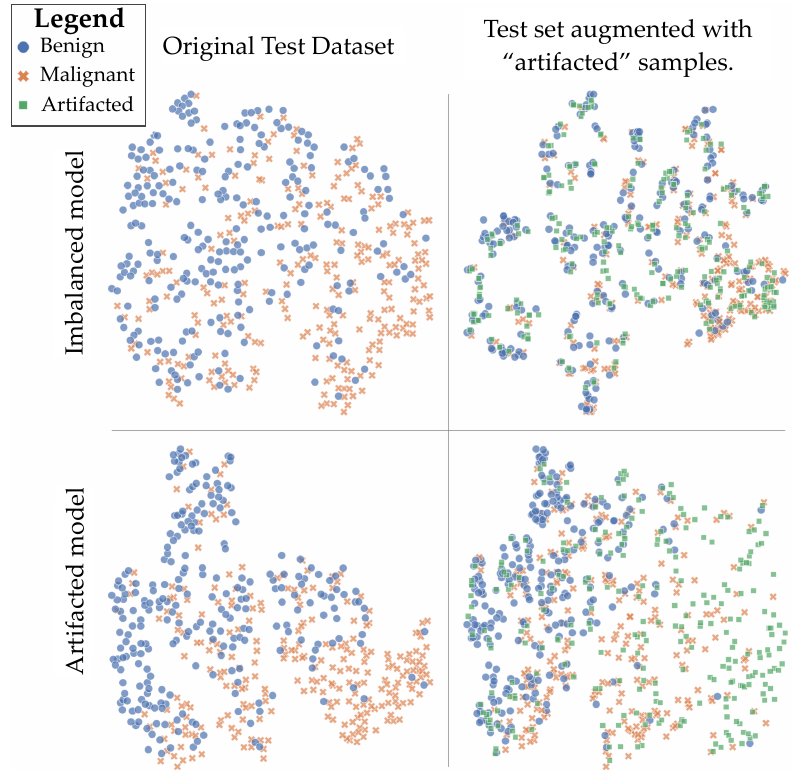
Figure 3. Examining D HMI in the latent space of models trained on D HMI test of t-SNE dimensionality reduction. Top row : imbalanced model; bottom row : “artifacted” model; left column : original test dataset, right column : test set augmented with “artifacted”